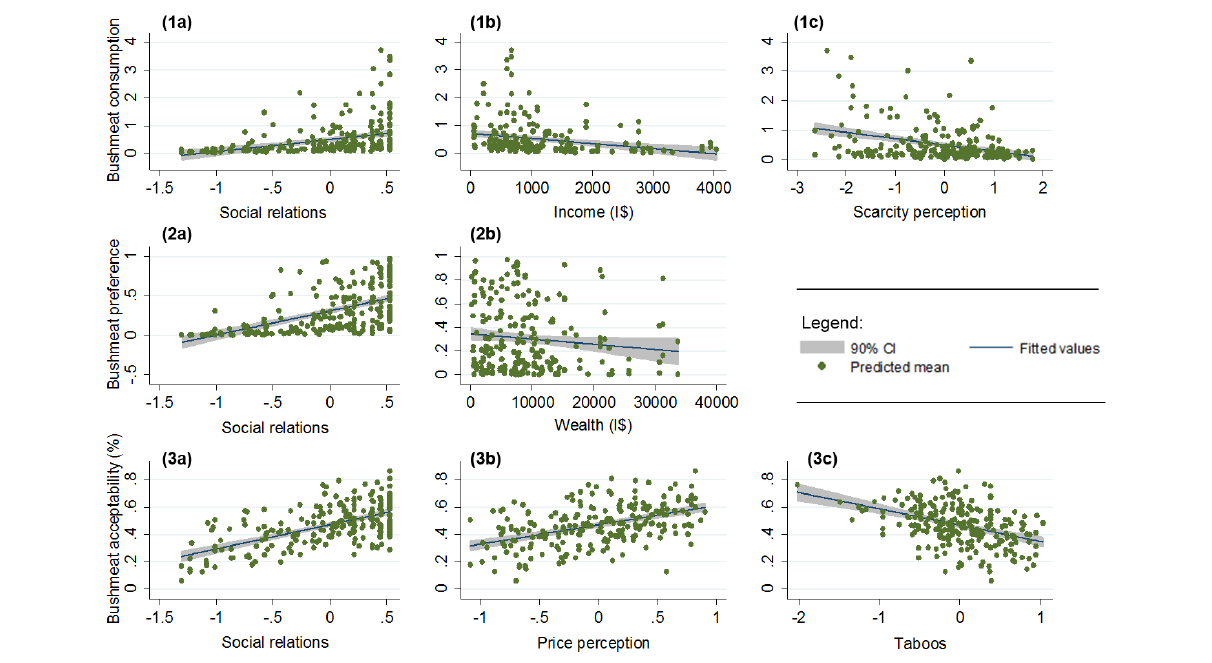
Fig. 5 . Scatterplots of significant correlates with bushmeat consumption (1a to 1c), preference (2a to 2b), and acceptability (3a to 3c). Y-axis values are predicted probabilities estimated from the full models.